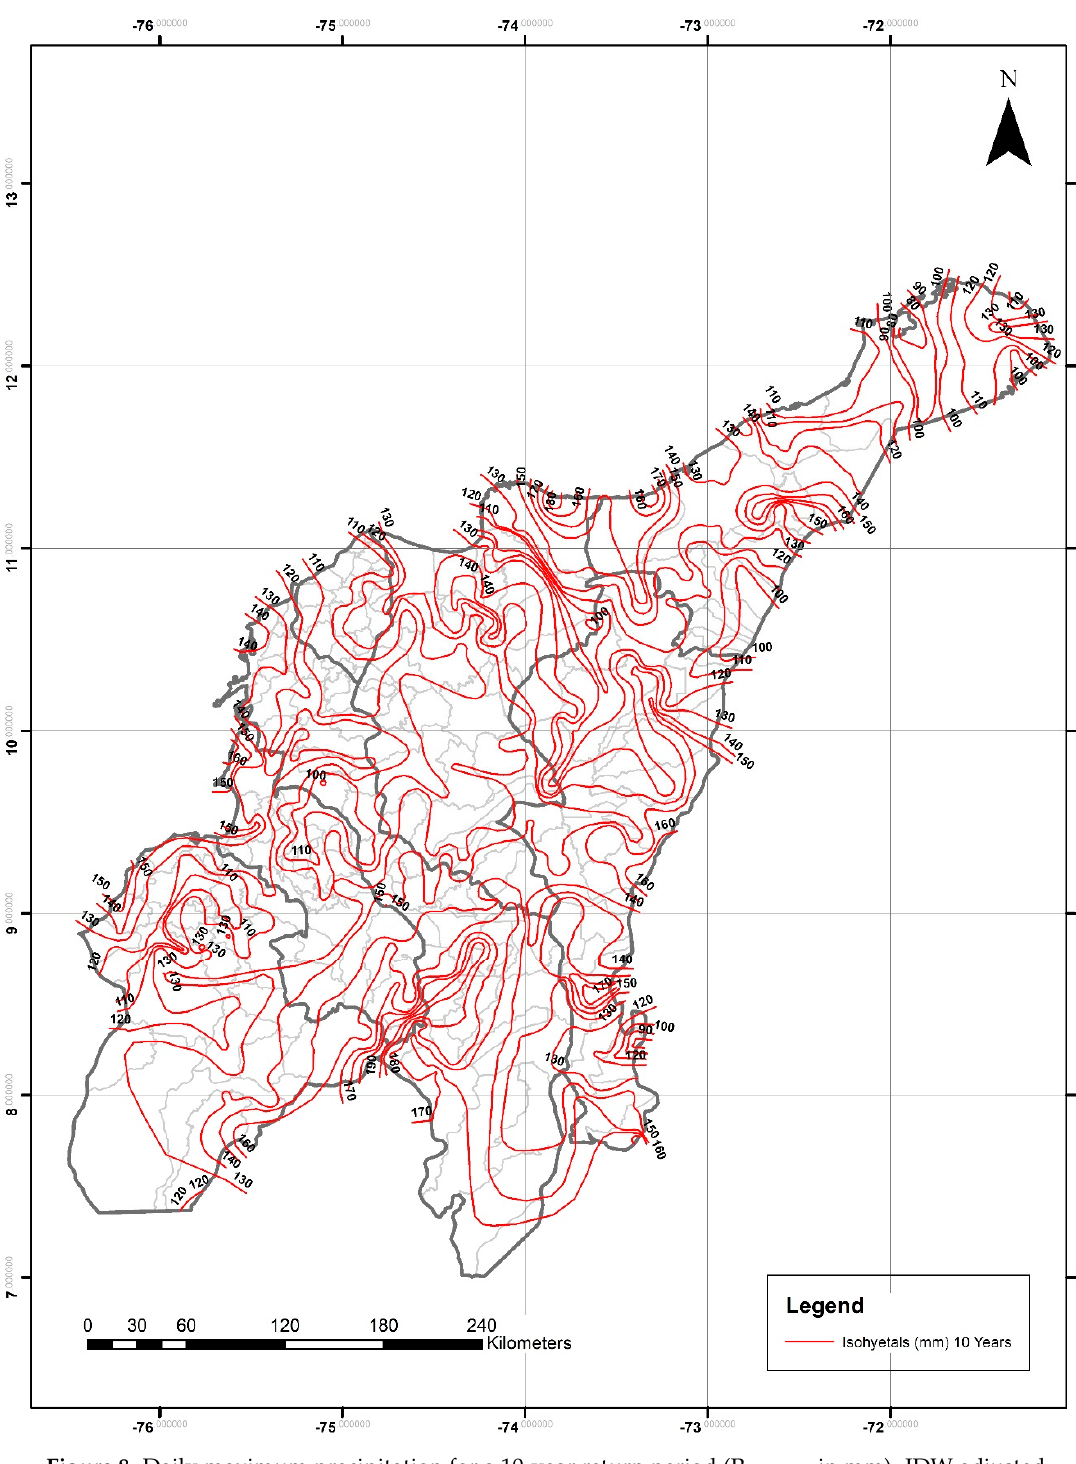
Figure 8. Daily maximum precipitation for a 10-year return period (P 24h-max in mm). IDW adjusted method. Light-gray lines are the boundaries of the different municipalities within the departments.